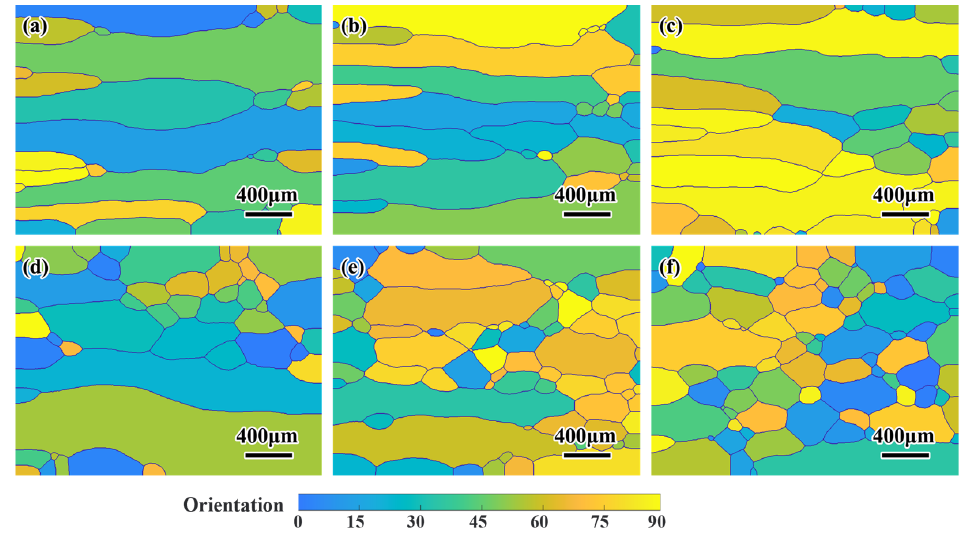
Figure 10. Simulated microstructures with different initial grain sizes after directional annealing at 3.3 μ m/s. ( a ) 11 μ m, ( b ) 22 μ m, ( c ) 45 μ m, ( d ) 55 μ m, ( e ) 69 μ m and ( f ) 99 μ m.